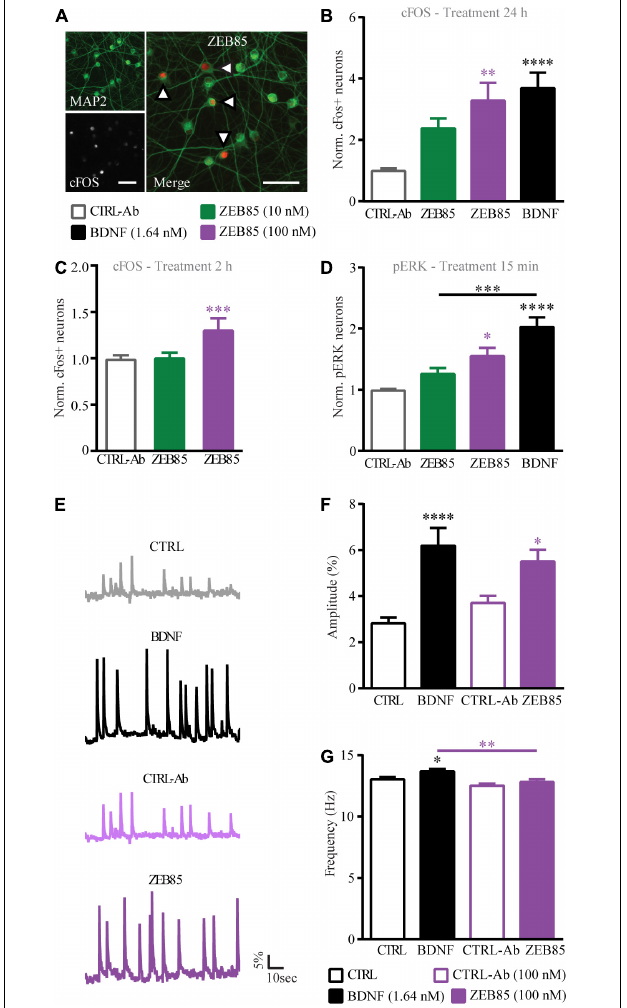
FIGURE 7 | ZEB85 induces cFOS and pERK expression and promotes intracellular calcium dynamics. (A) Primary hippocampal cultures DIV21 were immunostained for MAP2 (left insert above) and cFos (left insert below) or pERK (not shown). The arrows in the merged image (right) indicate cFOS expressing MAP2 positive neurons. Scale bar, 50 µ m. The number of cFOS/pERK positive neurons was calculated over total MAP2 positive neurons with a defined ROI, and is normalized to the controls (B–D) . Quantification of cFOS positive neurons treated for panels (B) 24 h (CTRL-Ab: n = 19 coverslips; BDNF: n = 20; ZEB85 10 nM: n = 9; ZEB85 100 nM: n = 11 coverslips; for 10 nM N = 4 independent experiments and for 100 nM; N =